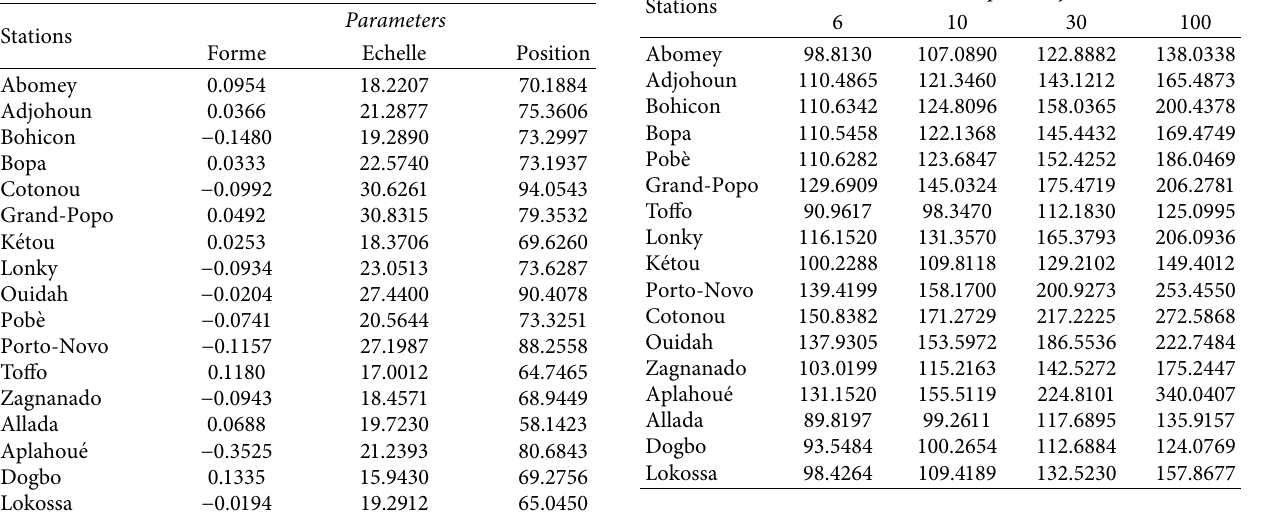
Figure 2: Spatial distribution of scale (a) and position (b) parameters. Table 2: Te rain quantiles (mm) obtained with Table 1: Te shape, scale, and position parameters calculated by maximum likelihood.